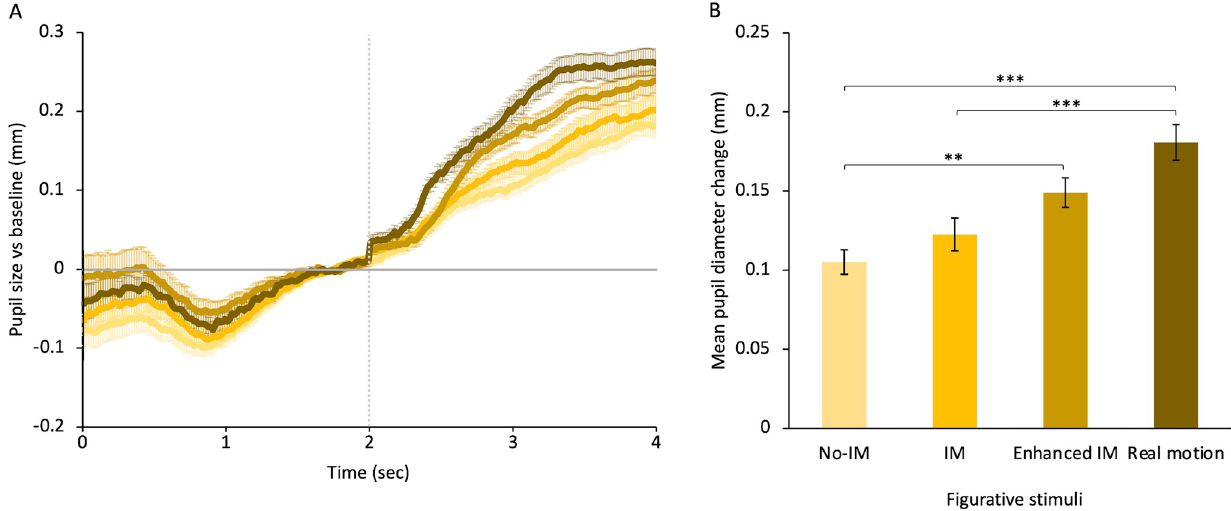
Fig 2. Pupillary responses to motion in figurative stimuli. (A) Baseline-corrected pupil size for the different figurative stimuli plotted as a function of time from trial onset. The horizontal line represents the baseline: Data over the zero-line represent pupil dilation whereas data under the line represent pupil constriction. The vertical line indicates the stimulus onset. Error bars are SE. (B) Mean pupillary diameter for different figurative categories during stimulus presentation. Categories include both objects/animals’ and humans’ subjects. Error bars are SE. Color saturation of the bars increases with motion strength, in order: Paintings with no implied motion (No-IM), paintings depicting simple implied motion (IM), paintings depicting enhanced implied motion (E-IM); movies of moving subjects (Real motion). See examples of paintings for each category in Fig 1A and 1B. Asterisks mark statistically significant pairwise comparisons across figurative motion categories: ��� p < 0.001, �� p < 0.01. All data shown have been corrected based on each observer’s motion rating test.